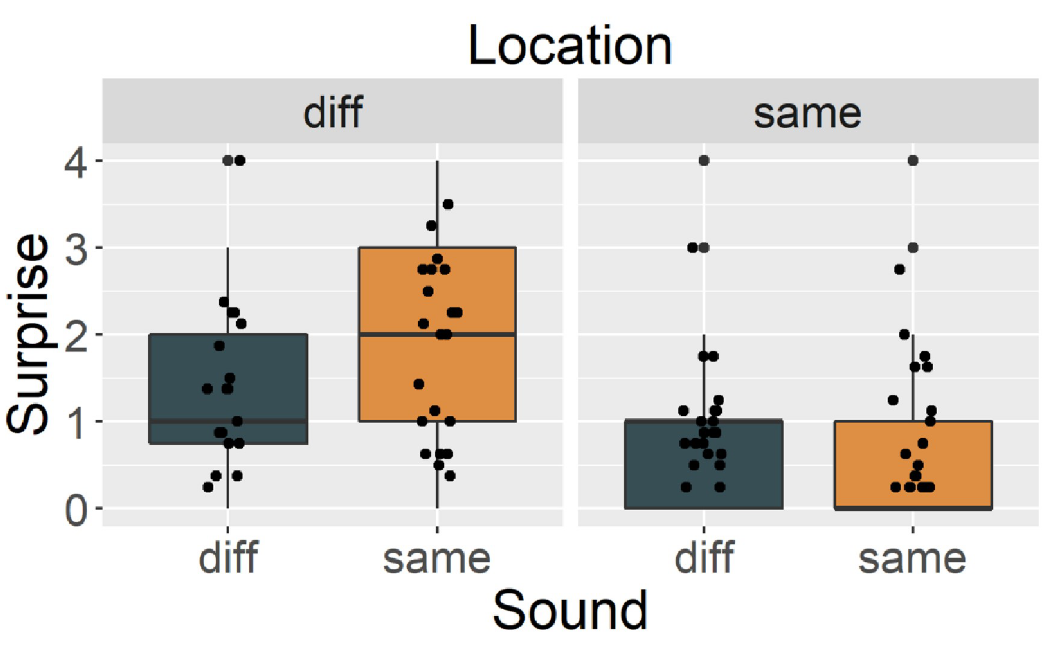
Fig 2. The magnitude of subjects’ surprise rated by eight blind raters in Exp.1. Black blue bar represents Diff sound . Orange bar represents Same sound . Left panel represents Diff location and right panel represents Same location . Each point represents mean magnitude of surprise for each trial.